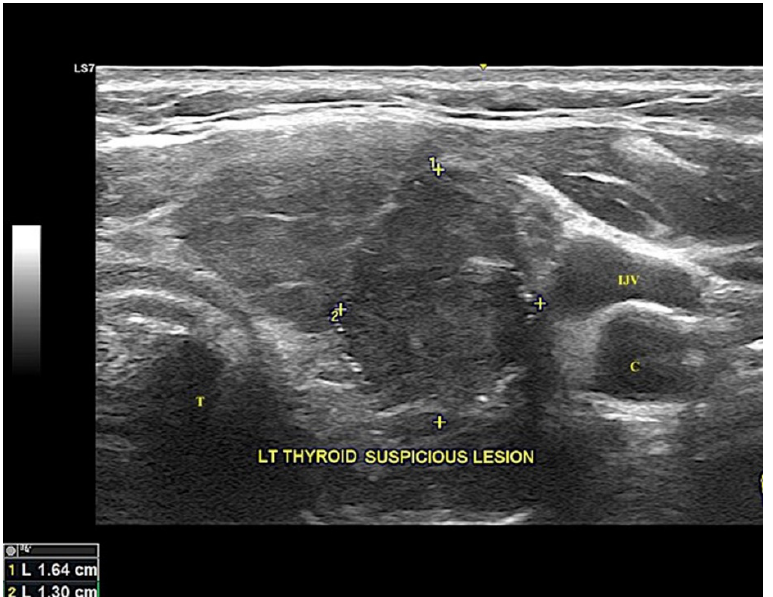
Figure 1. Ultrasonography image of the thyroid reveals a suspicious hypoechoic nodule with irregular border seen at the left thyroid lobe measuring 16.4 × 13.0 mm in diameter, outlined by “+”. Speckles of microcalcification are seen at the periphery. C = carotid artery, LT = left, IJV = internal jugular vein, T = trachea .